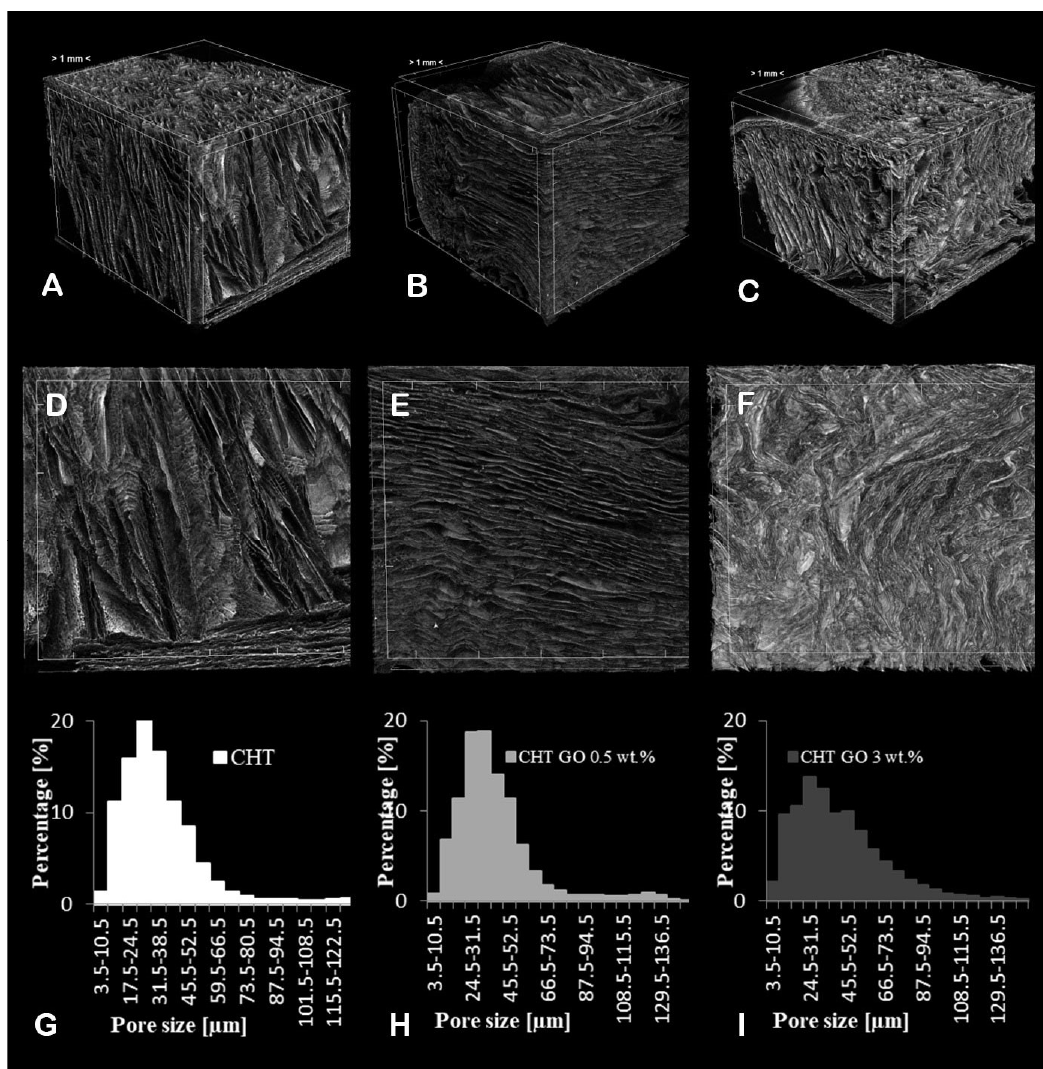
Figure 3. CHT/GO material characterization by MicroCT. Three-dimensional renderings of CHT ( A ), CHT/0.5 wt.% GO ( B ), and CHT/3 wt.% GO ( C ), with complementary cross-sections ( D , E , F ) and pore